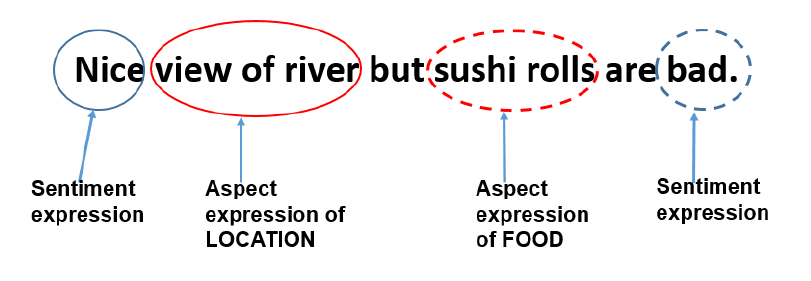
Figure 1. An aspect-based sentiment analysis example. The aspect expressions "view of river" and "sushi rolls" correspond to the sentiment expressions "nice" and "bad."